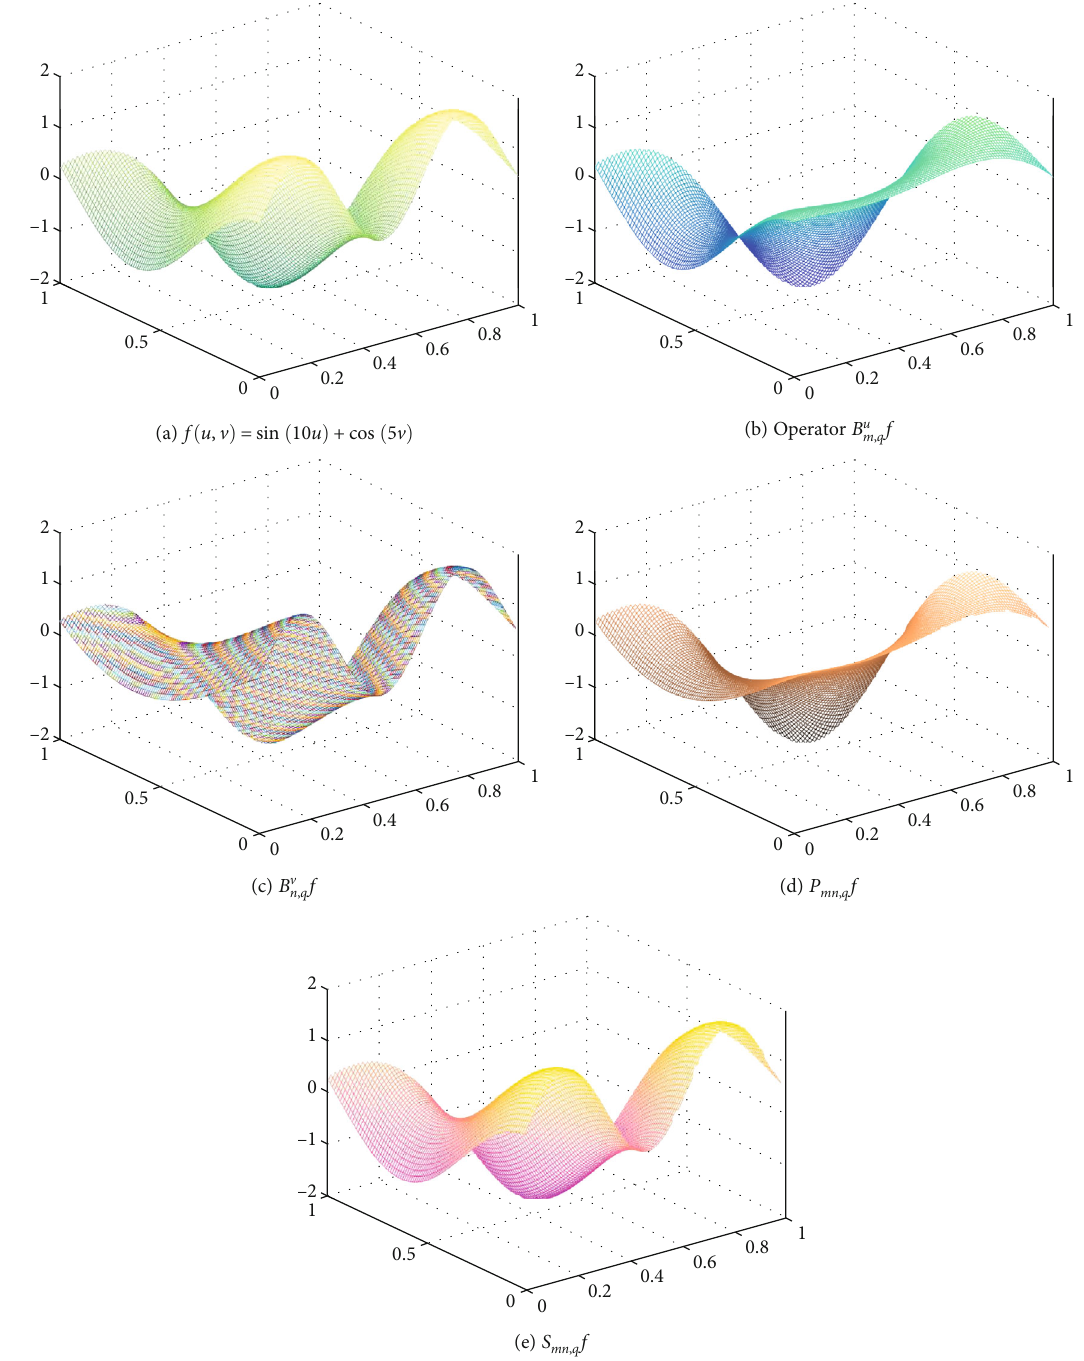
f , B v f , P f , and S f approximating function on triangular domain for h = 1 , m = 15 , n = 15 , and q = 0 : 70 mn , q mn , q m , q n , q